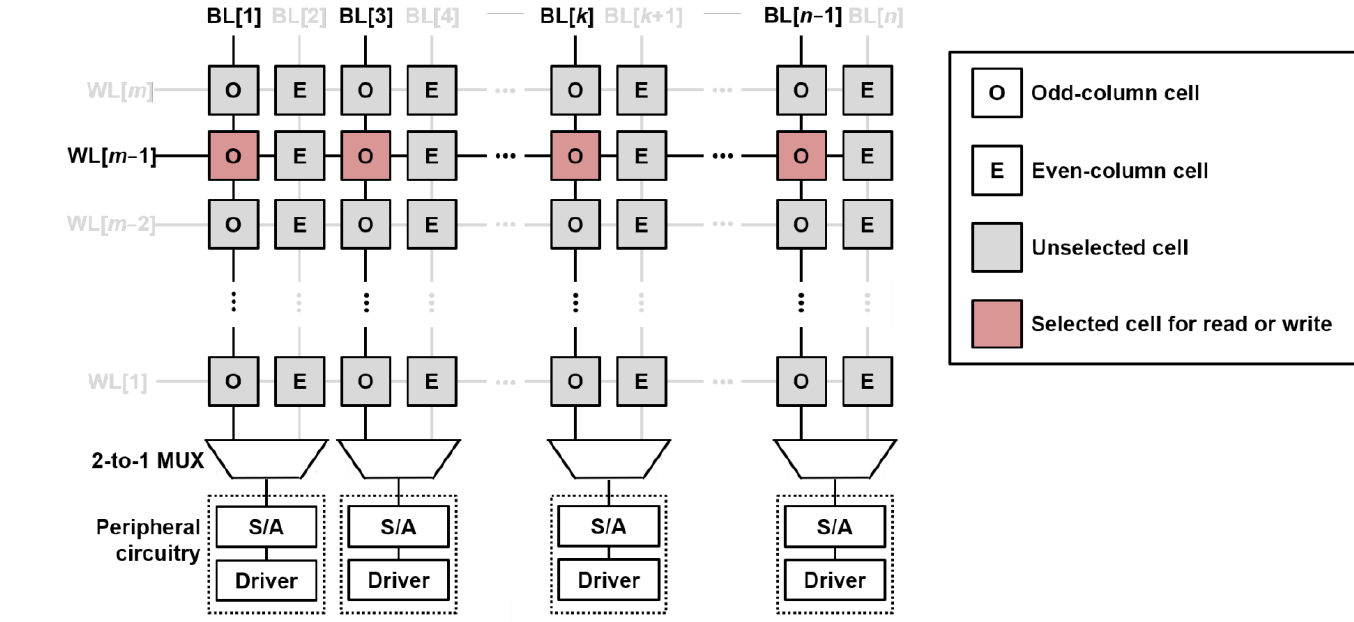
Figure 4. Illustrative example of distance-2 bit-interleaving architecture.